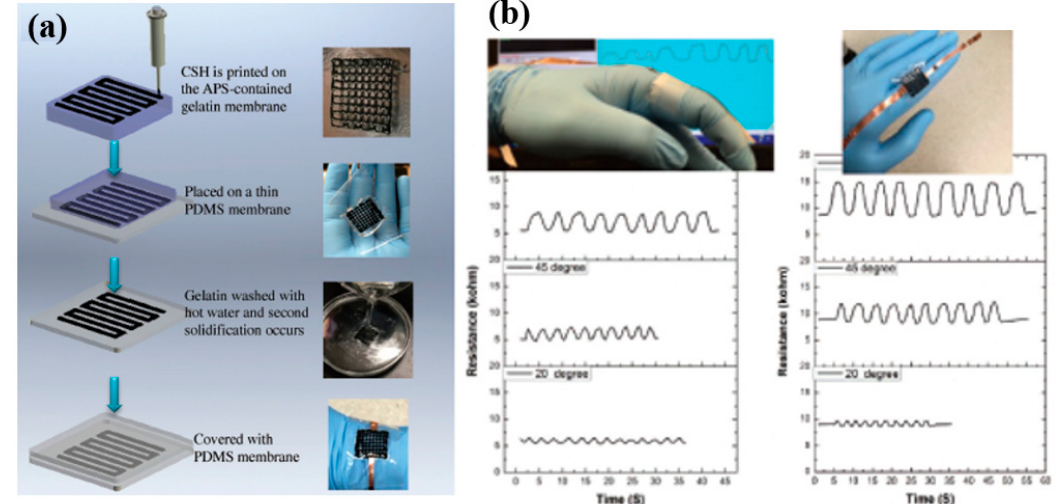
Figure 15. Three-dimensional (3D) printing characterization, preparation, and application. ( a ) Preparation of a 3D-printed wearable sensor with the CSH hydrogel. A real-time bodily motion monitoring system using smartphones and a 3D-printed CSH wearable and flexible sensor; ( b ) resistance variation of the CSH hydrogel strip (left) and 3D-printed sensor (right) attached onto the index finger, as the finger was subjected to repeated bending and relaxing from 0° to 20°, 45°, and 90° [155] (reproduced with permission).